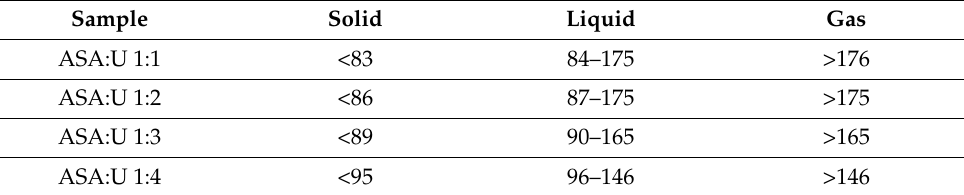
Table 3. Temperature ( ◦ C) dependence of the phase state of the ammonium sulfamate–urea system. Sample